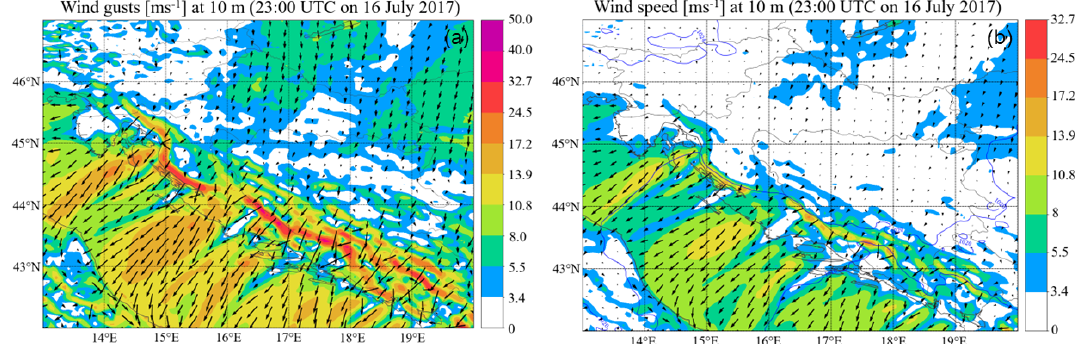
Figure 10. (a) Wind gusts (ms − 1 ; vector and colored contour) at 10m. (b) Winds (ms − 1 ; vector and colored contour) at 10m and MSLP (mean sea level pressure; blue contours), both valid for 23:00UTC on 16 July 2017 from the ALADIN-HR44 model.